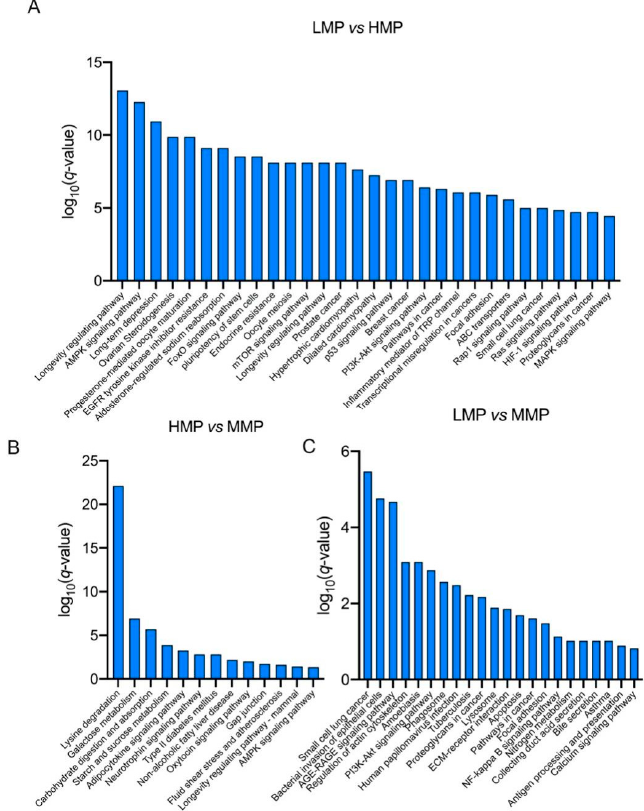
Figure 3. KEGG pathways enrichment of differential proteins in plasma between ( A ) LMP and HMP, ( B ) HMP and MMP, ( C ) LMP and MMP. LMP: low milk protein concentration group; MMP: medium milk protein concentration group; HMP: high milk protein concentration group. The group presented before the symbol “vs” was a control group.